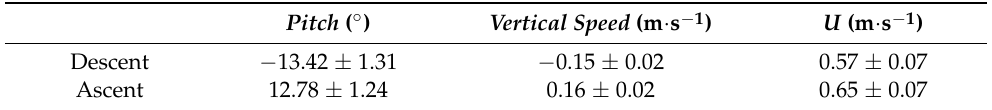
Table 2. Mean ± 1 standard deviation of the hybrid AUV flight parameters of the mission (Note. θ is the pitch angle, W is the vertical speed, and U is the speed through the water).